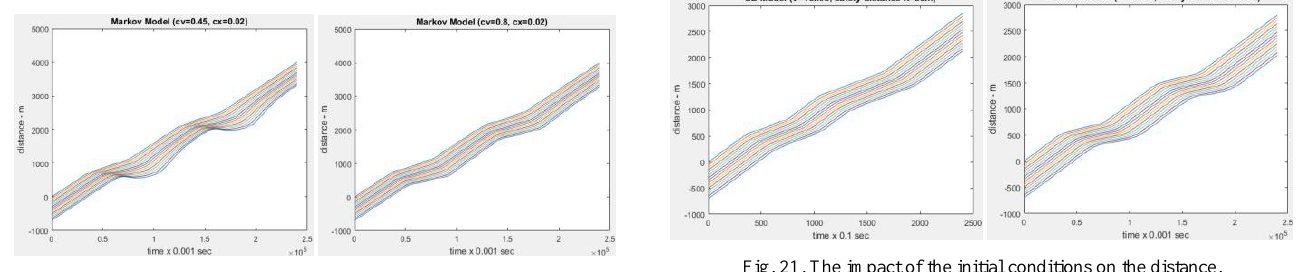
Fig. 16. The impact of Markov model parameters on the distances.